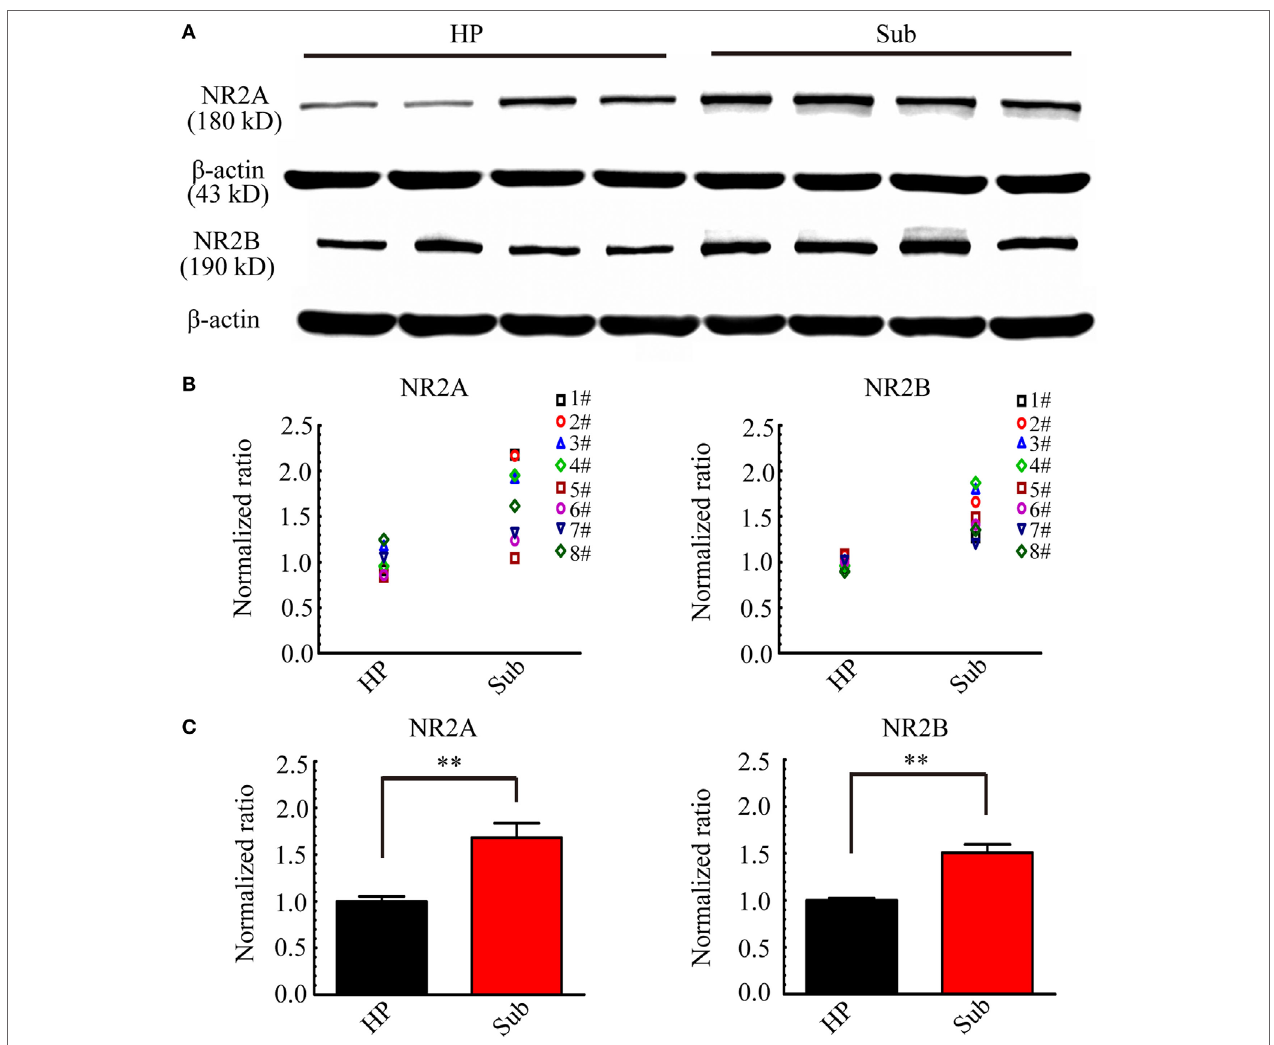
FigUre 11 | nr2a and nr2B expression levels in the hippocampus proper (hP) and the subiculum . (a) Examples of Western blots of the NR2A and NR2B in the HP and the subiculum (Sub). (B,c) Protein levels were quantified by densitometric signals obtained from Western blots. NR2A and NR2B protein levels in the subiculum were normalized to the corresponding protein level in the HP. The normalized protein levels in each mouse were displayed in (B) , and the averaged normalized protein levels of eight mice were displayed in (c) . The levels of NR2A and NR2B protein in HP were significantly lower than that in the subiculum (** P < 0.01, paired t -test, n =